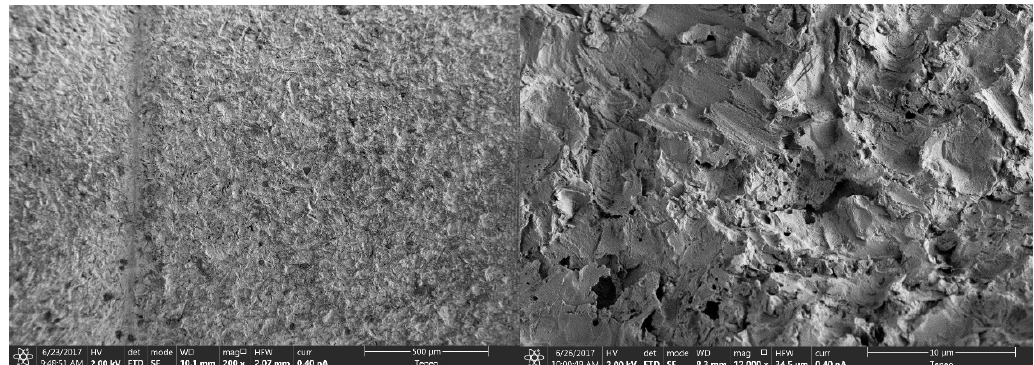
Figure 8. SEM images of the surface of HA blast, and non-etching acid wash (HA + AW) 200× ( left ) and 12,000× ( right ).